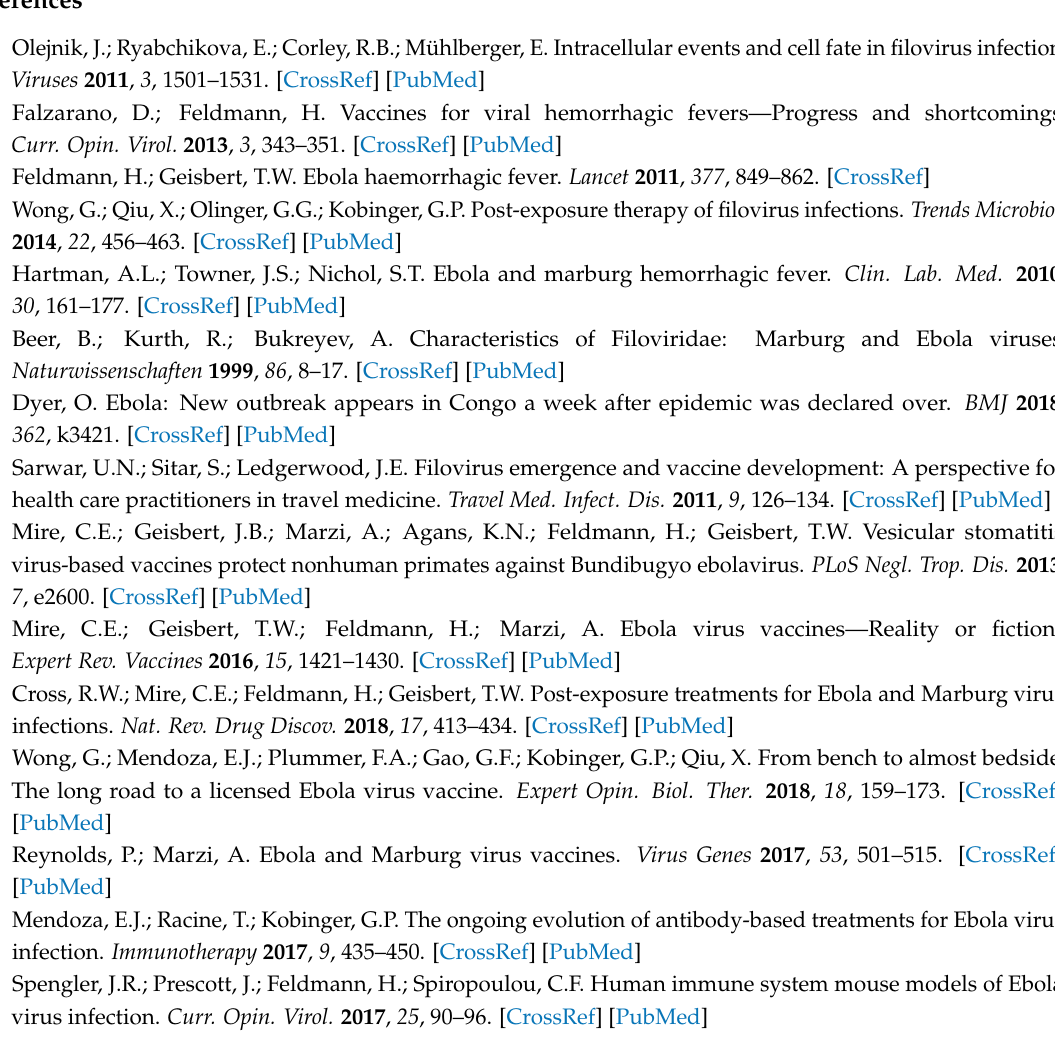
Figure S1: Representative immunostaining of EBOV viral antigens in viral antigen-positive foci. Figure S2: Higher magnification images of the inserts in Figure 1A. Figure S3: Cytotoxicity of DMSO, ESI09, NY0123, and I942 in HUVECs. Figure S4: Pharmacological inactivation of EPAC1 protects different ECs from EBOV or MARV infection. Figure S5: Effect of pharmacological manipulation of EPAC1 on Akt-1 phosphorylation in